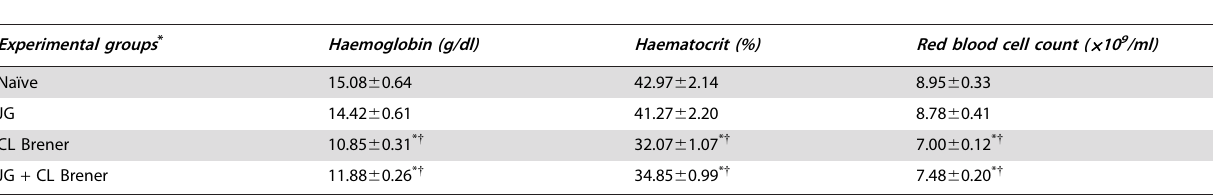
Table 2. Hemoglobin level, hematocrit and red blood cell count in JG and/or CL Brener infected mice at 21 days p.i.